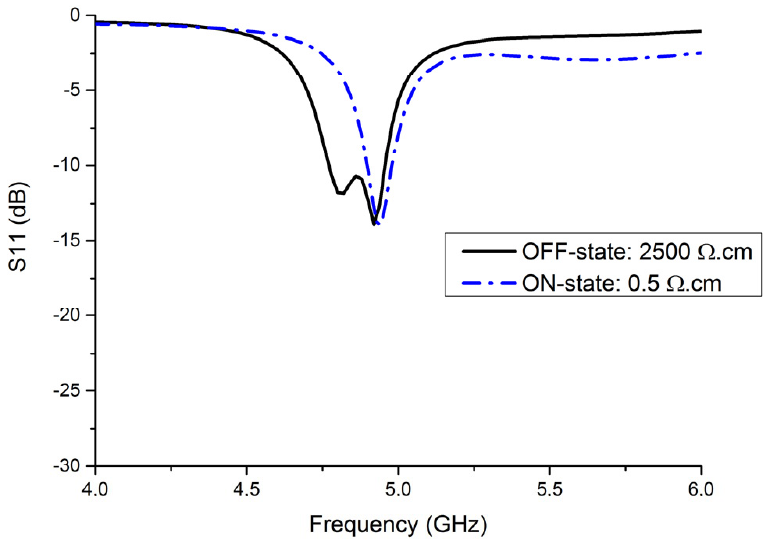
Figure 11. S 11 simulated results of circular to linear polarization reconfigurable antennae in both